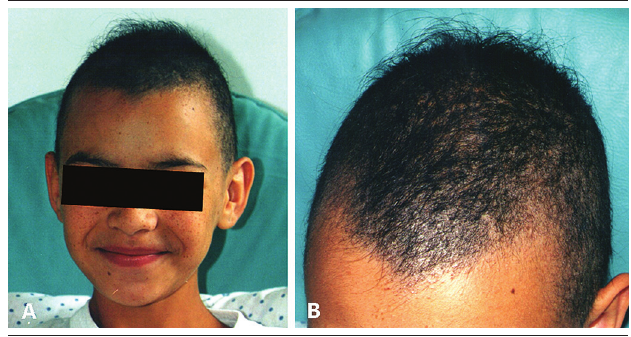
figurE 2 − Images of the patient at 10 years of age showing diffuse and irregular alopecia with hair rupture at different levels, giving an appearance of hypotrichosis (A and B)